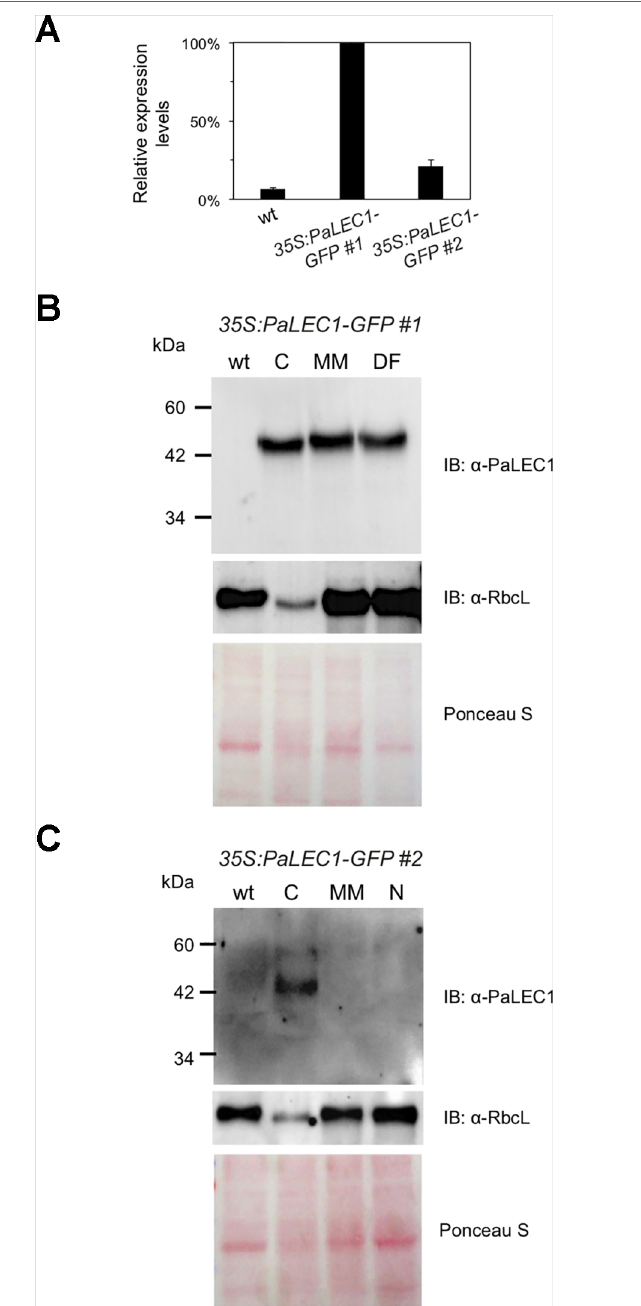
FIGURE 3 | Expression of PaLEC1-GFP protein in 35:PaLEC1-GFP transgenic lines. (A) Quantitative RT-PCR analysis of expression of PaLEC1-GFP in wild-type (wt) and two 35:PaLEC1-GFP transgenic lines. (B) Western blotting showing expression of PaLEC1-GFP and PaRbcL proteins in callus-type, multiple-meristem type, and dorsal fi n-like embryonic tissues of 35:PaLEC1-GFP #1 plants. (C) Western blotting showing expression of PaLEC1-GFP and PaRbcL proteins in callus-type, embryonic tissues of 35:PaLEC1-GFP #2 plants. Blots stained with Ponceau S staining were used to visualize total loaded protein. wt, wild-type plants; C, callus-like tissues; MM, multiple meristem-like structures; DF, dorsal fi n-like structures; N, normal wt-like